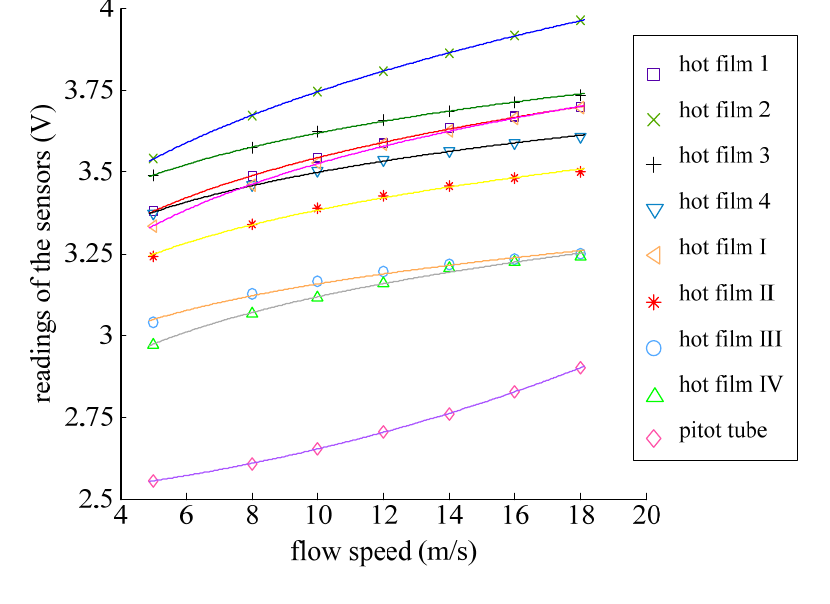
Figure 4. Monotone relationships between sensor readings and flow